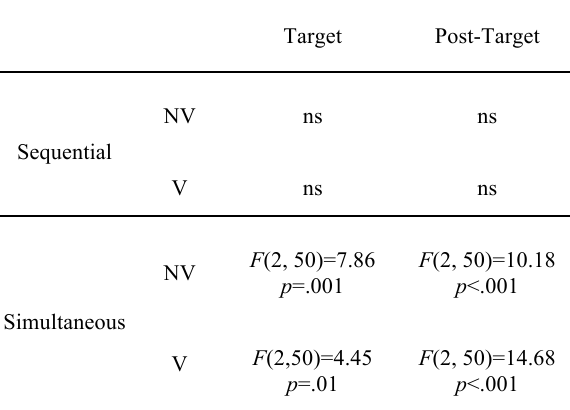
Table B. Statistics for DT on the target and post-target (errors as co-variate) Target Post-Target